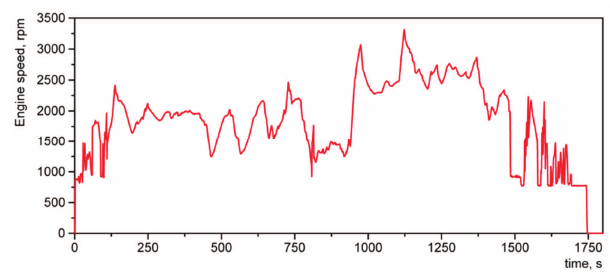
Fig. 5. Crankshaft speed as a function of driving time The engine was at idle at first (about 750 rpm) and then the crankshaft speed increased as the vehicle accelerated to about 2,500 rpm (Fig. 4). Speed in the further part of the drive was not relatively constant as in the first period of time, i.e. 250-750 s it ranged from 1,400 to 1,700 rpm and later, i.e. 1,000-1,300 s increased and ranged between 2,300 and 2,600 rpm (Fig. 5).